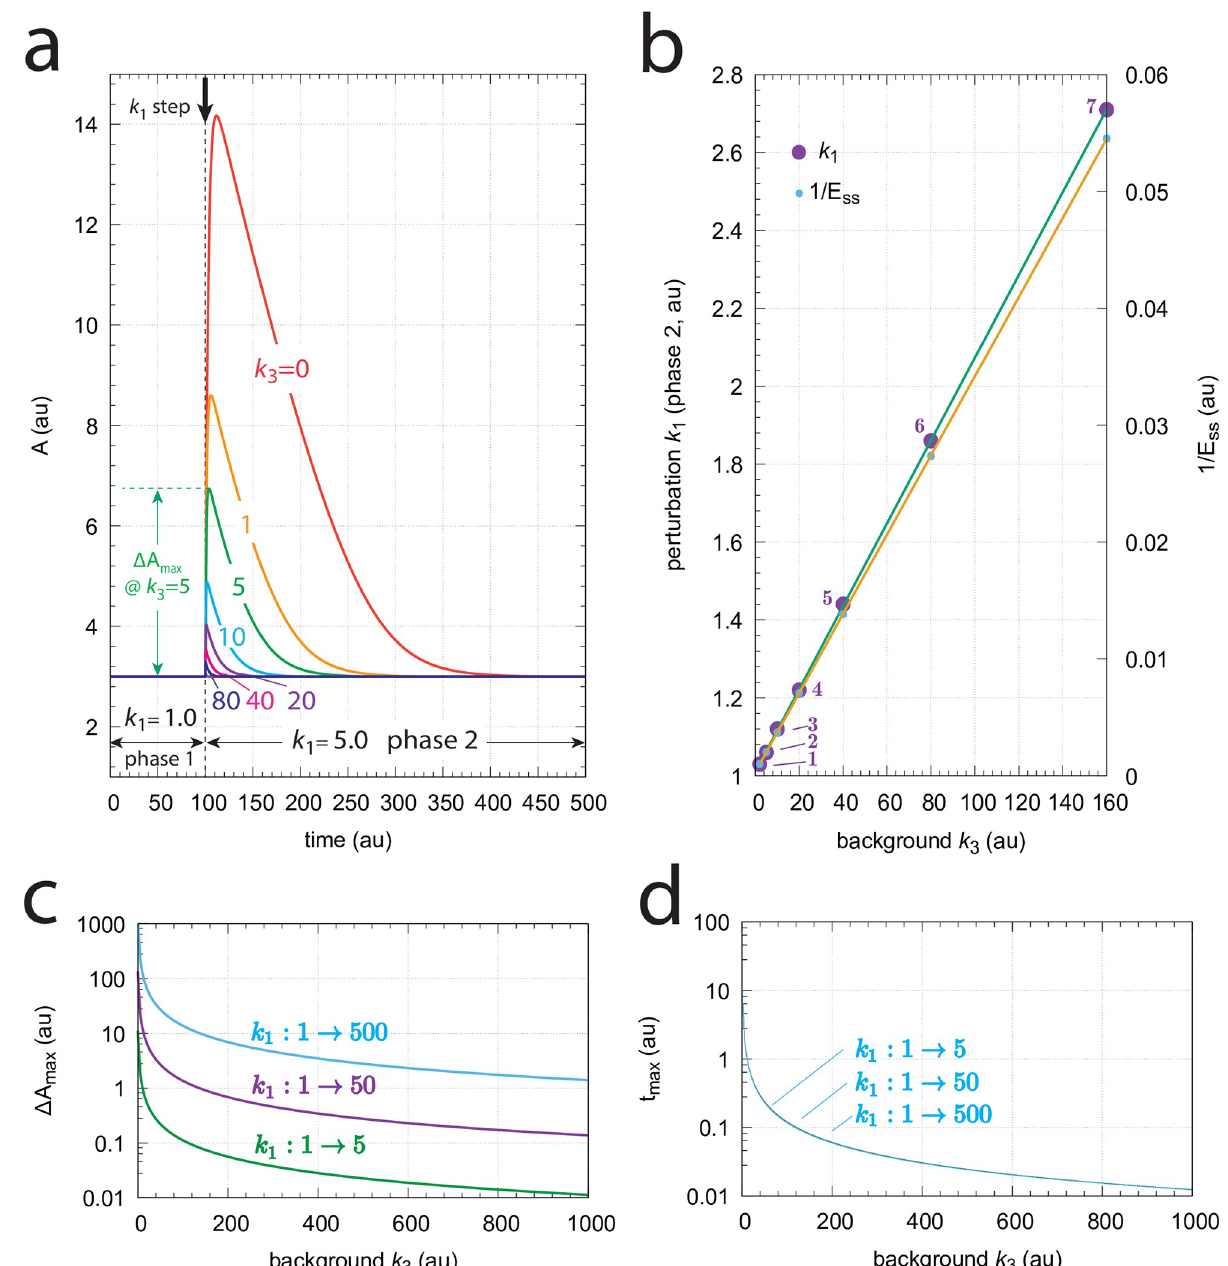
Fig 11. Response kinetics and relationship to Weber’s law in the m8 controller (Fig 10). The set-point of A is A set =3.0. (a) Step-wise increase of k 1 from 1.0 to 5.0 at time t =100 at different and constant background perturbations k 3 (0–80). Note the successive decrease in the excursion of A ( Δ A and the more rapid A resetting to the set-point at increased k 3 values. Rate constants (in au): k 1 =1.0 (phase 1), k 1 =5.0 (phase 2), k 2 =0.0, k 3 variable, k 4 = 1 × 10 4 , k 5 =620.0, k 6 =20.0, k 7 =1 × 10 − 6 , k 8 = k 9 =0.1. Initial concentrations (in au): A 0 =3.0, E 0 =2999.90 ( k 3 =0); A 0 =3.0, E 0 =1499.90 ( k 3 =1); A 0 =3.0, E 0 =499.90 ( k 3 =5); A 0 =3.0, E 0 =272.63 ( k 3 =10); A 0 =3.0, E 0 =142.76 ( k 3 =20); A 0 =3.0, E 0 =73.07 ( k 3 =40); A 0 =3.0, E 0 =36.94 ( k 3 =80). (b) Relationship to Weber’s law: the perturbation k 1 and (1/ E ss ) in phase 2 are linear functions of the background perturbation k 3 when k 1 is adjusted such that a “just noticable difference” of Δ A =0.03 is observed. Rate constants and initial concentrations as in (a), except that k 1 in phase 2 has the following values: 1 , max k 1 = 1.0319 ( k 3 = 2); 2 , k 1 = 1.0637 ( k 3 = 5); 3 , k 1 = 1.1169 ( k 3 = 10); 4 , k 1 = 1.2231 ( k 3 = 20); 5 , k 1 = 1.4356 ( k 3 = 40); 6 , k 1 = 1.8604 ( k 3 = 80); 7 , k 1 = 2.7111 ( k 3 = 160). (c) Δ A values as a function of background k 3 for three step perturbations in k 1 . Like for the m7 controller the three curves are max congruent and their shape can be moved onto each other. (d) t max as a function of background k 3 . For a given background t max values are practically the same independent of the three steps. Rate constants in panels (c) and (d) are the same as for panel (a), apart from k 1 and k 3 . Initial concentrations are taken as the steady state values for A and E at the different backgrounds k 3 prior to the applied step in k 1 .